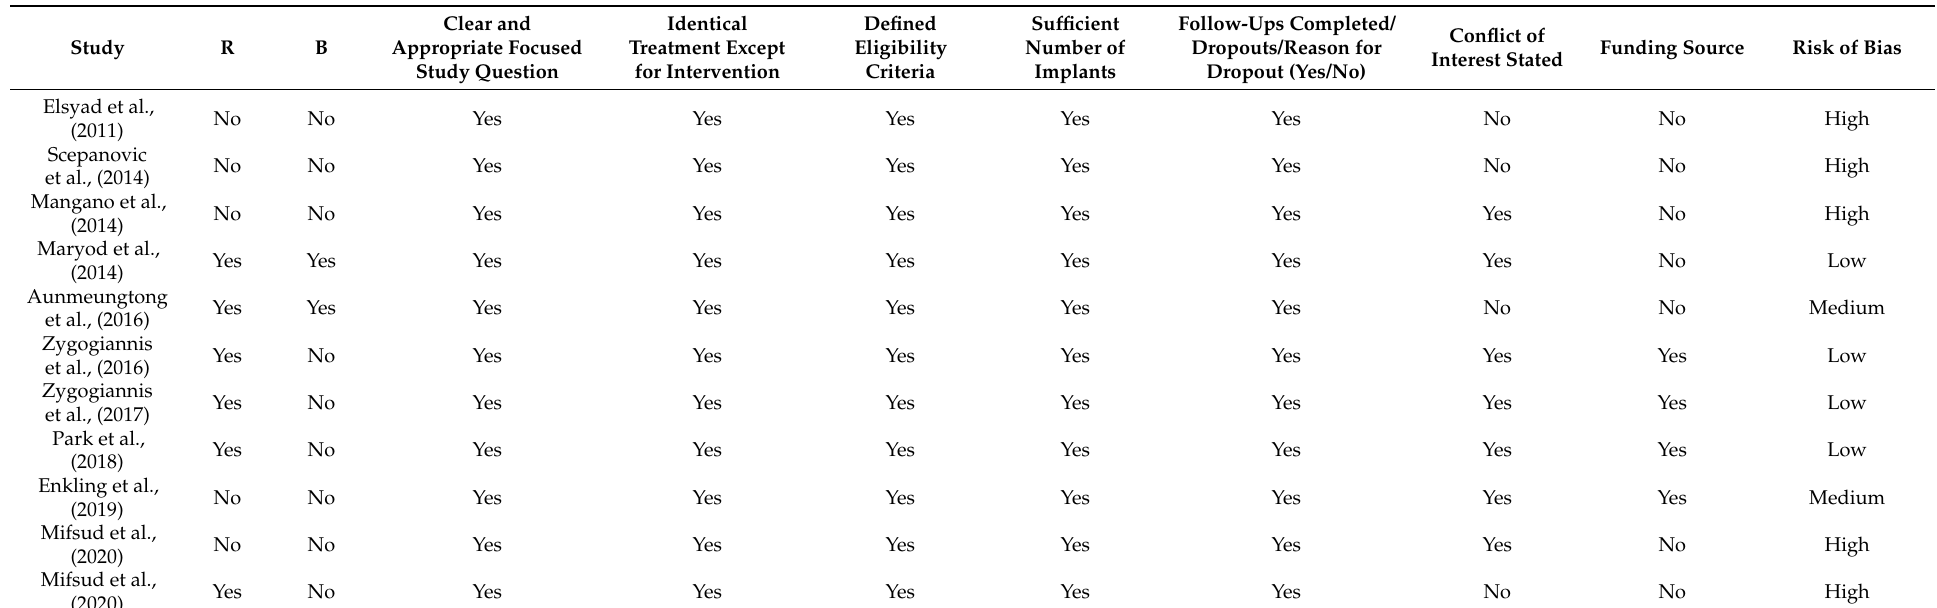
Table 3. Quality assessment of studies included in the systematic